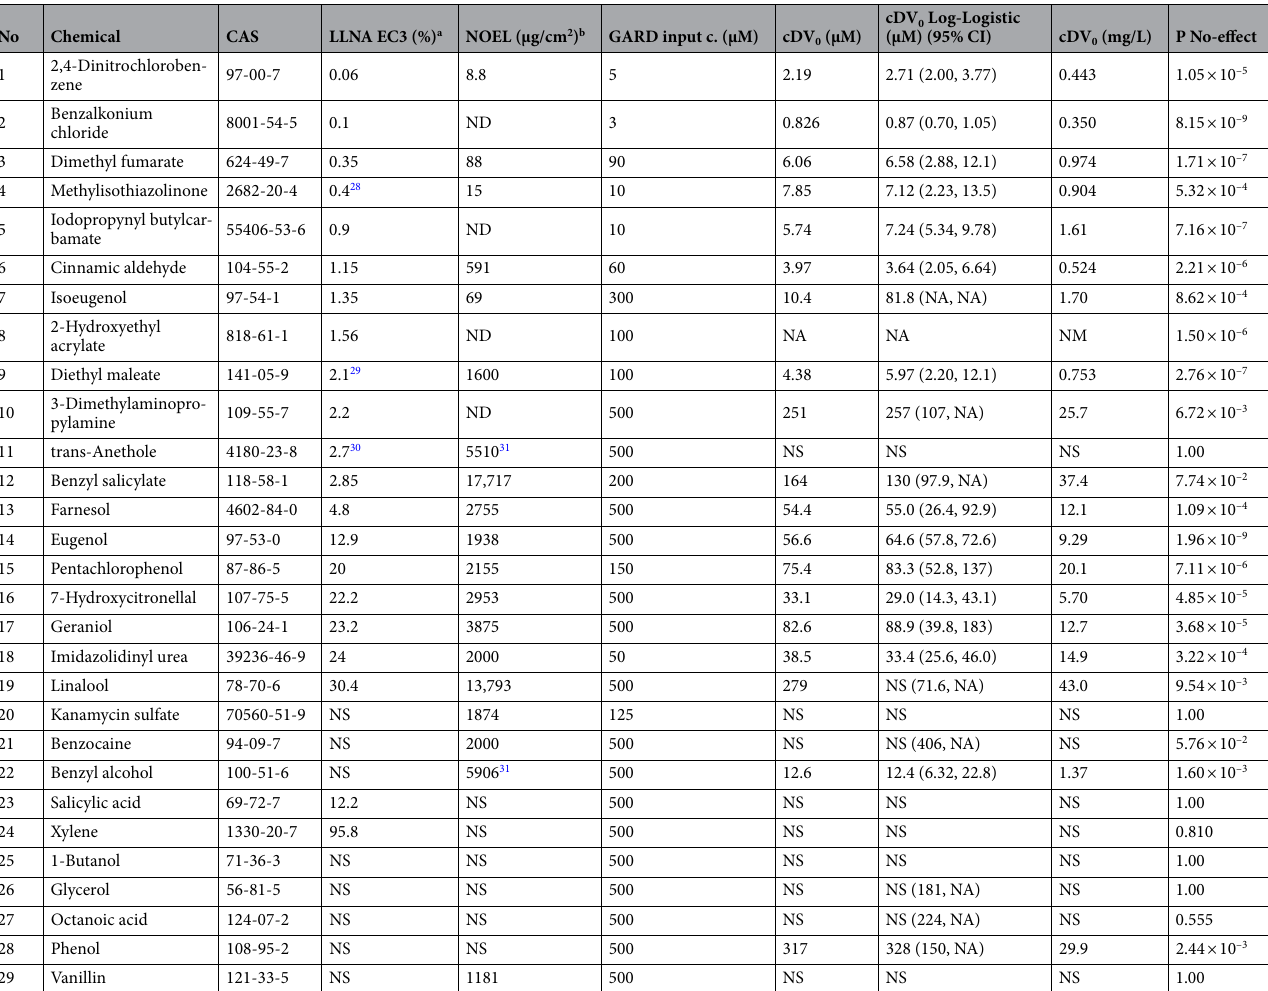
Table 1. Chemicals used to assess the GARDskin dose–response methodology and their measures of skin sensitizing potency and estimated cDV 0 values. NA Value could not be defined, ND Data insufficient for defining a NOEL, NS Non-sensitizer. a Reference-data for LLNA EC3 values were, unless otherwise stated, obtained from Hoffman et al. 32 . b Reference-data for human NOEL values were, unless otherwise stated, obtained from Basketter et al. 33